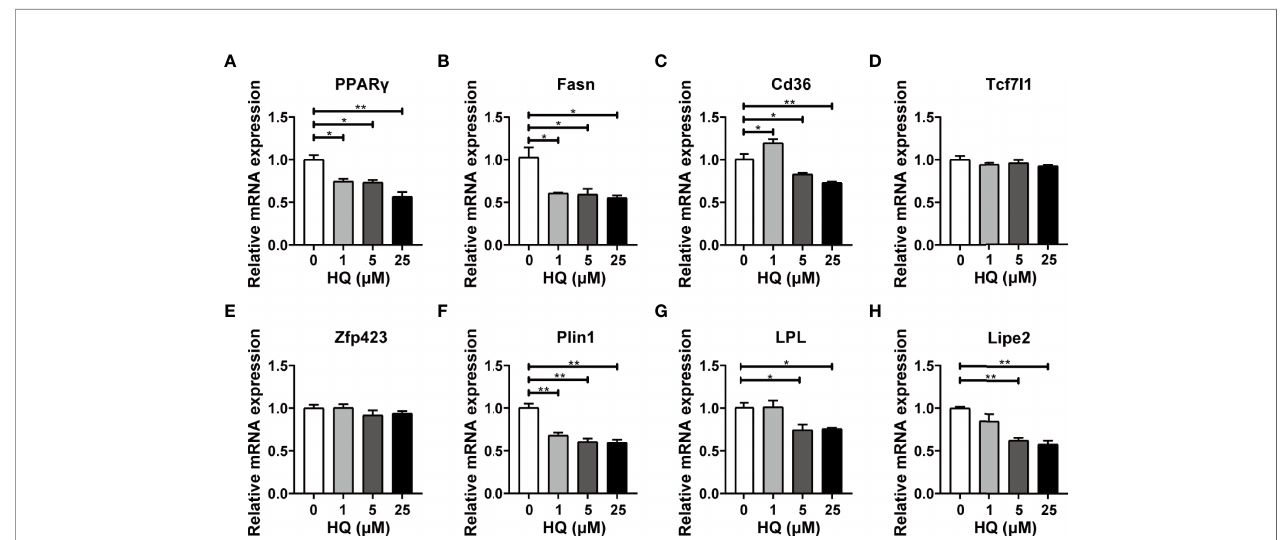
FIGURE 7 | Effect of HQ on mRNA levels of lipid metabolism genes in adipocytes. The mRNA expression of genes involved in lipogenesis (A – E) and lipolysis (F – H) were examined in 3T3-L1 adipocytes after 24-hour exposure to HQ, respectively. Data are presented as mean ± SD (n = 3-6). One way ANOVA were performed; * p < 0.05, ** p < 0.001 (compared to the control